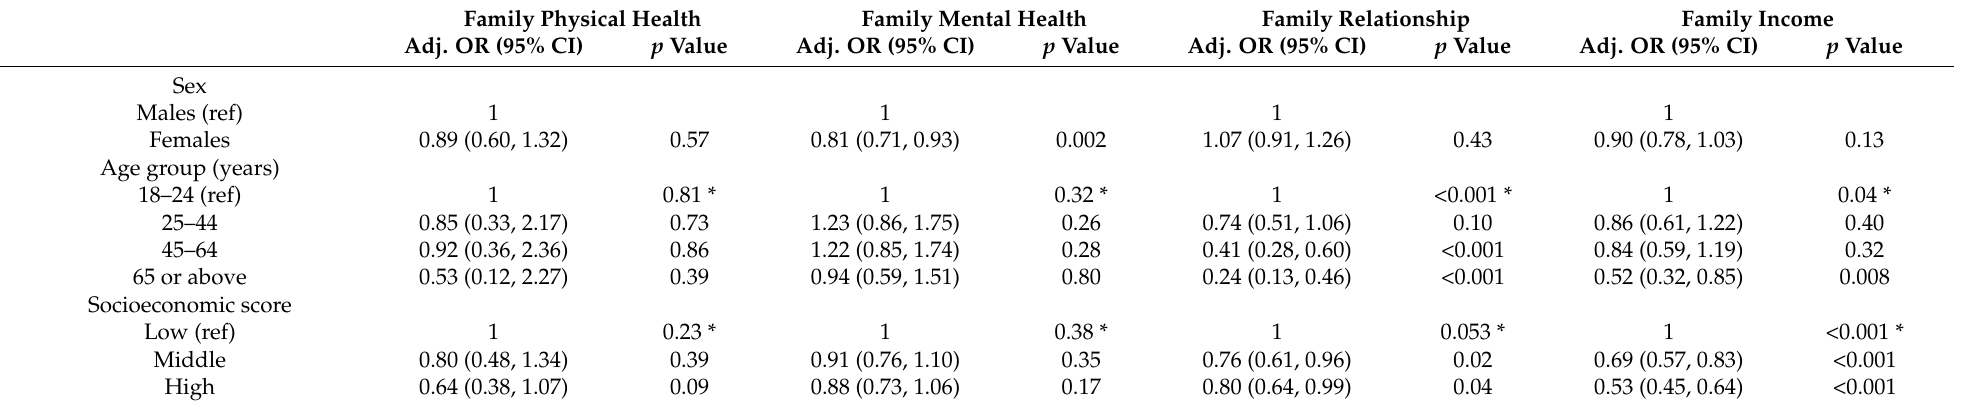
Table 5. Association of perceived harms of COVID-19 on family well-being with demographic and socioeconomic